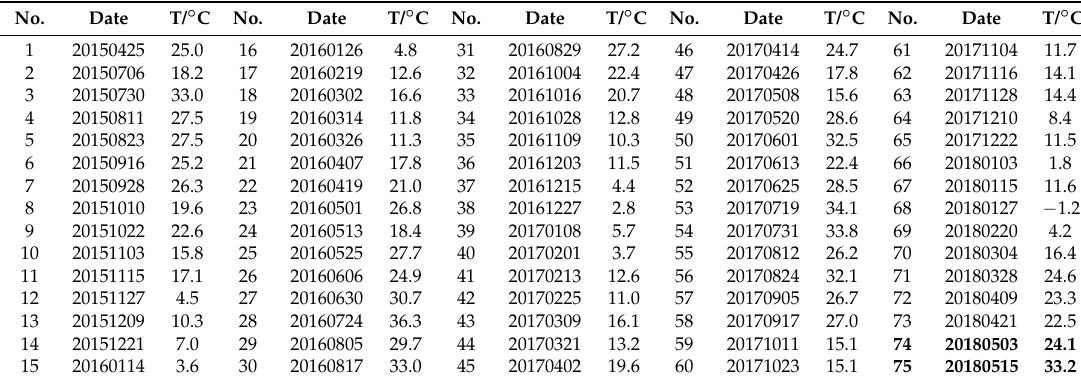
Table 1. Sentinel-1 SAR image dataset of Track 01 (the non-bold group is used for displacement modeling and the bold one for health evaluation).